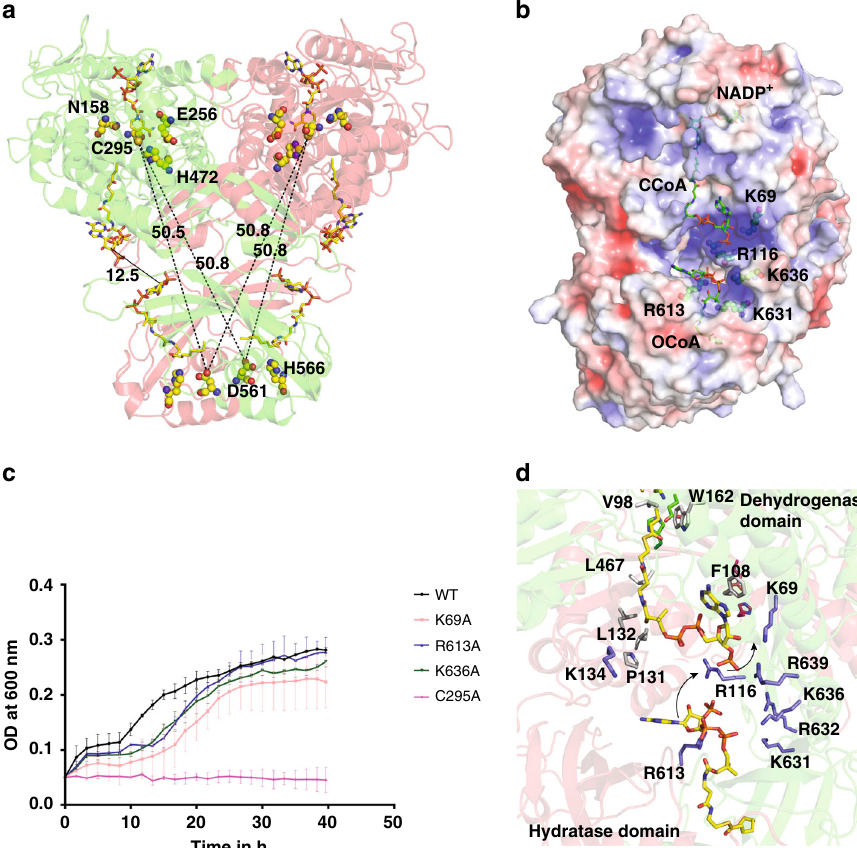
Fig. 5 Substrate transfer pathway in PaaZ. a Cartoon representation of PaaZ dimer, monomers colored in red and green. The active site residues and ligands are shown in sphere and stick representation, respectively. The distance between the active site residues between the two catalytic centers measured from the same monomer or adjacent monomer is ~51 Å. The ligands OCoA and CCoA from the two structures are used as reference to show the relative positions of the substrates in each enzymatic domain. The distance between the substrates measured from C3 carbon is ~12.5 Å. Note that the OCoA ligand placed in the hydratase domain of the PaaZ CCoA structure is not an experimental structure. b Electrostatic (ABPS) potential of PaaZ dimer colored between − 5 to 5 kT. The positive patches at this interface region indicate that the substrate from the hydratase domain might be attracted and guided into the tunnel of the dehydrogenase domain. Key positively charged residues are shown in sphere representation. c Growth curves of E. coli K12 Δ paaZ transformed with plasmid encoding PaaZ variants — WT, K69A, R613A, K636A and the control C295A. All 3 alanine mutants of the positive charged residues showed slower growth compared to WT, when grown in a minimal media with PA as the sole carbon source. The mutant K69A was the slowest suggesting its role in transfer of substrate from hydratase domain to dehydrogenase domain. Error bars re fl ect the s.d. of three independent experiments ( n = 3). The source data are provided as a Source Data File. d A close up view of the substrate transfer pathway in PaaZ, colored as in panel a . The